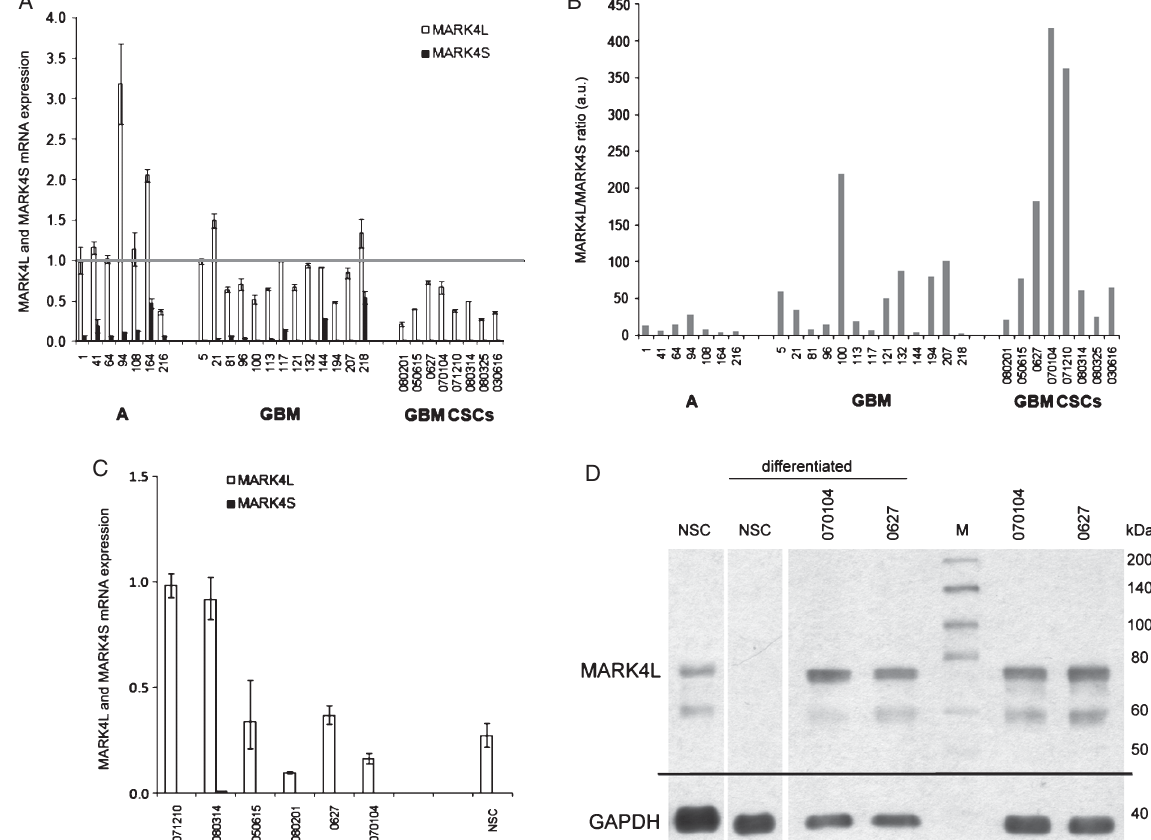
Fig. 4. MARK4 expression profile in GBM CSCs and NSCs. (A) Relative expression of MARK4L (white bar) and MARK4S (black bar) mRNA in A, GBM and GBM CSCs compared with HNB (set as 1 and represented as a horizontal grey line). Data were normalized to GAPDH and (cid:2) -actin and analyzed by the (cid:1) Ct method. (B) MARK4L/MARK4S mRNA ratio in A, GBM and GBM CSCs. (C) MARK4L (white bar) and MARK4S (black bar) transcript levels in GBM CSCs and mouse NSCs compared with HNB (set as 1). Data were analyzed with the (cid:1)(cid:1) Ct method using 18S rRNA as the endogenous control. Real-time data are expressed as mean ± standard deviation. (D) Immunoblotting for MARK4L in undifferentiated and differentiated GBM CSCs (070104, 0627) and NSCs. The membrane was cut (black line) after the blocking step and incubated with the appropriate antibodies. M, molecular weight ladders